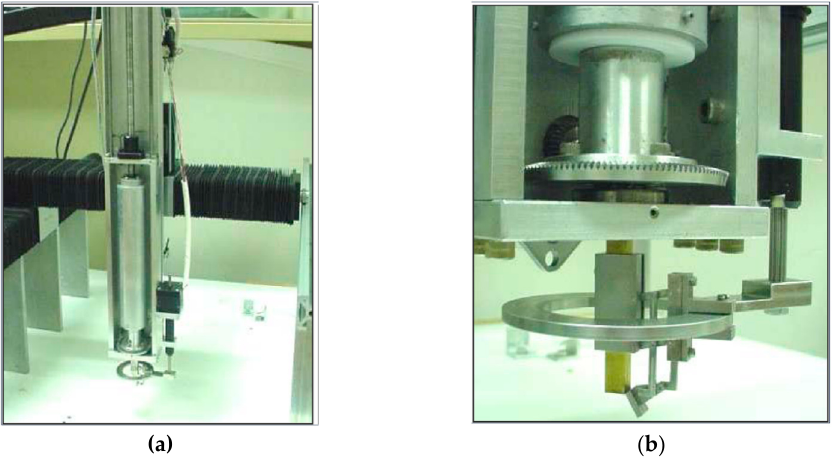
Figure 15. Installation of the print head: ( a ) extruder sits on an x-y-zgantry robot. ( b ) details of nozzle assembly. Reprinted with permission from ref. [77]. Copyright 2003 Elsevier